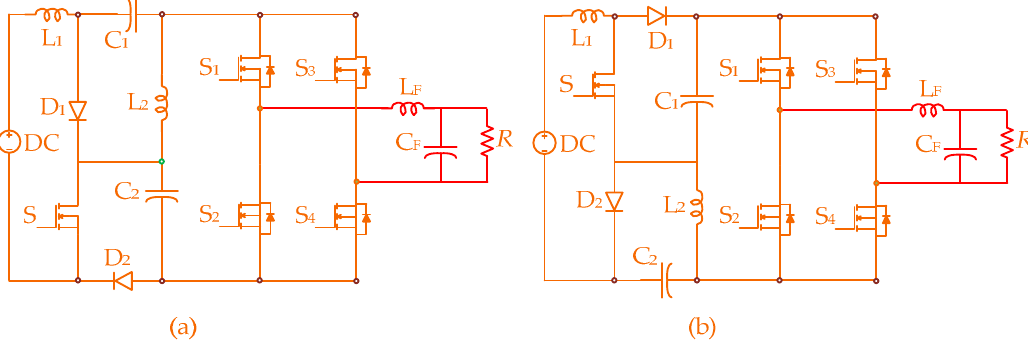
Figure 18. High-gain quasi-switched boost inverter topologies ( a ) Type 1; ( b ) Type2. The voltage multiplier cells are widely used in the power conversion process to pro- duce higher voltage gain and to reduce stress on the components. A voltage multiplier